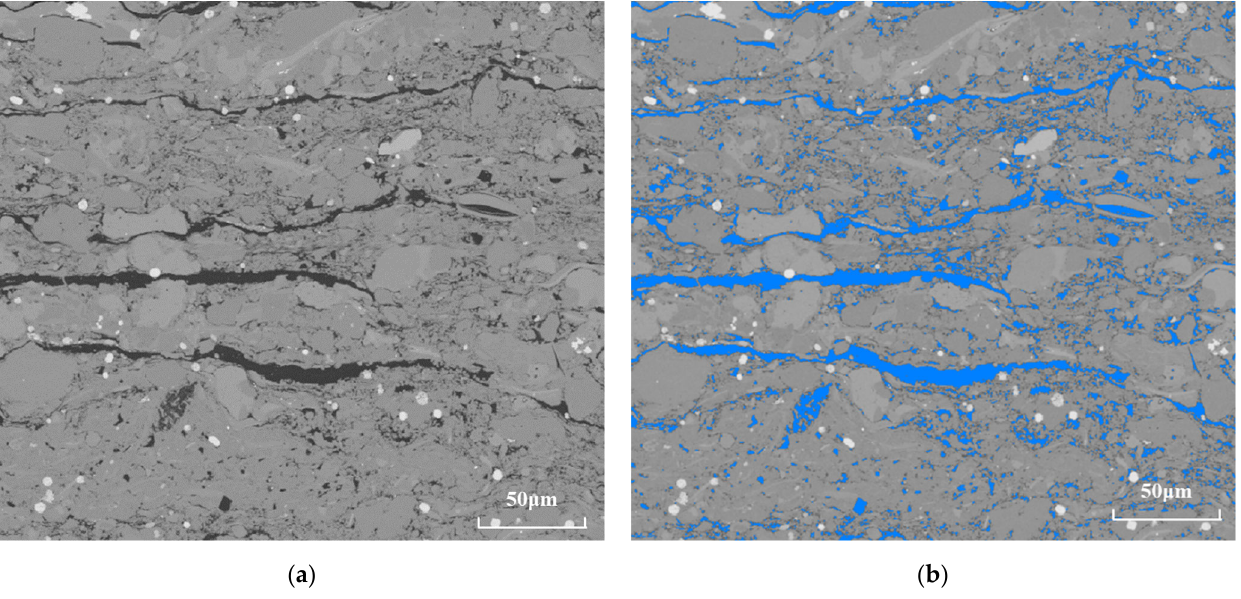
Figure 16. Scanning electron microscope images of shale matrix of the L7 samples with high perme ‐ ability. ( a ) Original image. ( b ) Organic matter demarcated as blue.